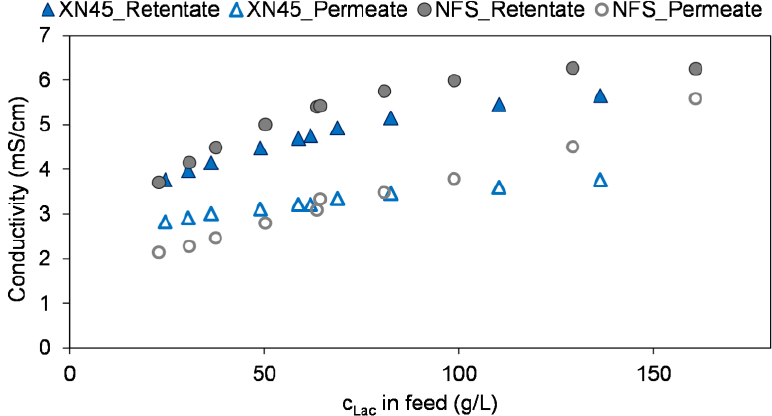
Figure 6. Resulting permeate flux (J) and retention (R%) of lactose during concentration of lactose model solution (Lac) versus whey permeate (WP); ( a ) XN45 (20 °C & 3 MPa); ( b ) NFS (45 °C & 2 MPa). Operation parameters summarized in Table 3.